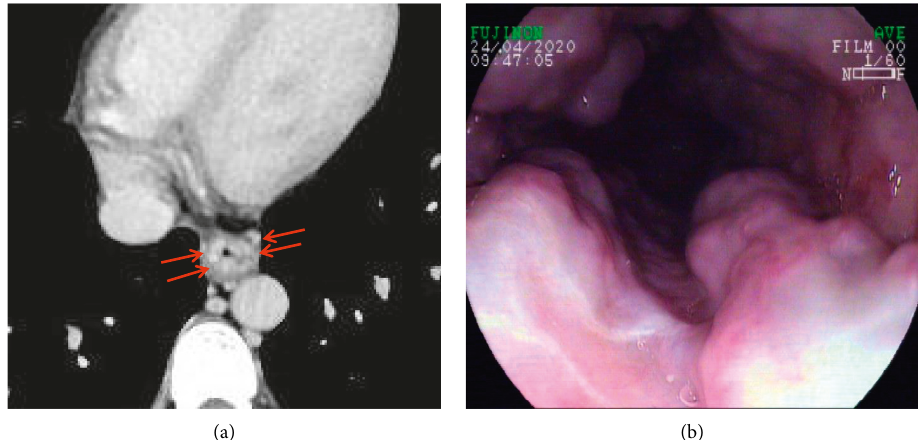
Figure 3: Esophageal varices. In a 38-year-old male with liver cirrhosis, the axial contrast-enhanced CT scan (a) on the portal vein phase demonstrated that esophageal varices (red arrow) were enhanced channels adjacent to the surface of the esophageal lumen, with round, tubular, or scalloped borders. Upper gastrointestinal endoscopy (b) showed several tortuous varices in the